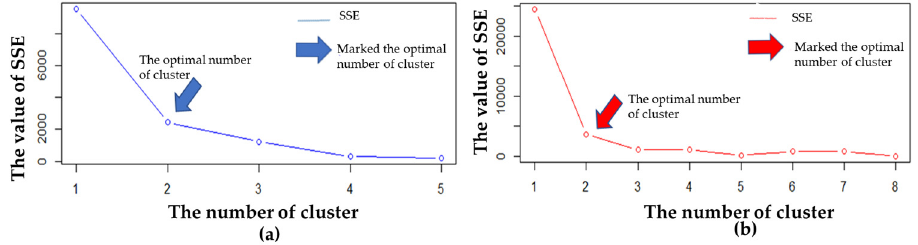
Figure 8. ( a ) The optimal number of clusters for the medium EDRI category (The blue arrow indicates the optimal number of clusters); ( b ) The optimal number of clusters for high EDRI in cluster type I (The red arrow indicates the optimal number of cluster)